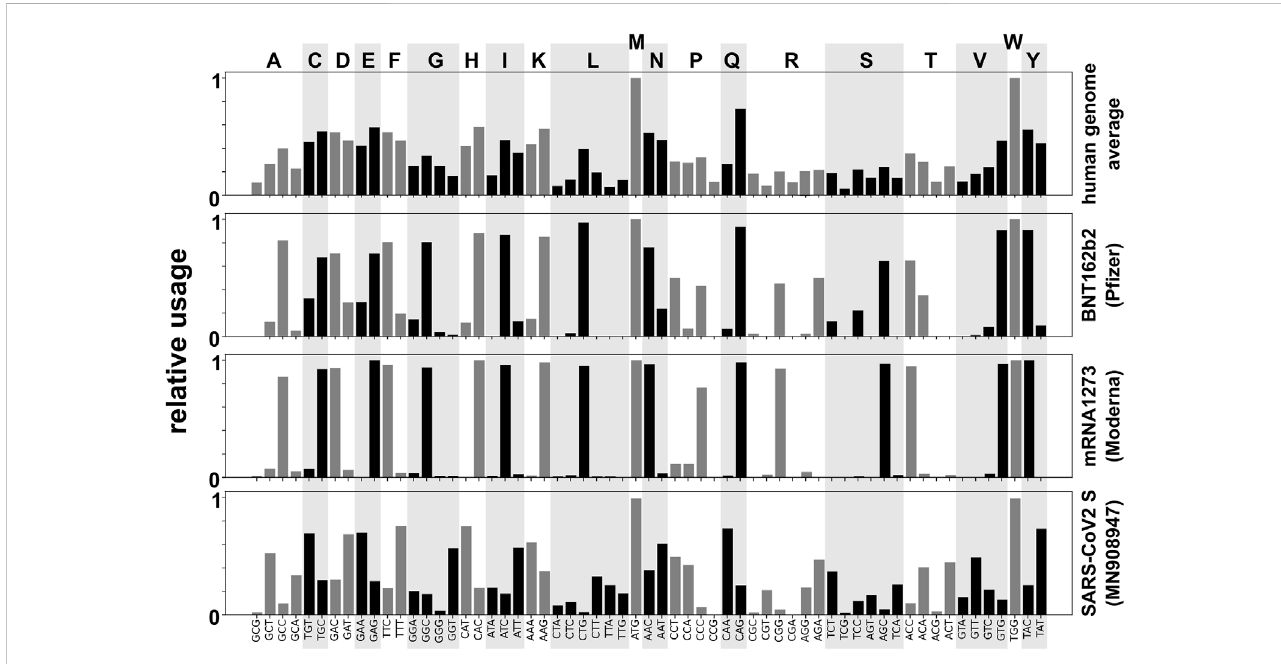
FIGURE 5 CodonusageforsensecodonsintwoclinicallyusedSARS-CoV-2vaccines,comparedtotheaveragecodonusageinopenreadingframesinthehuman genome (top) and to codon usage in a representative native spike protein encoding sequence from SARS-CoV-2 (bottom, from Genbank ID